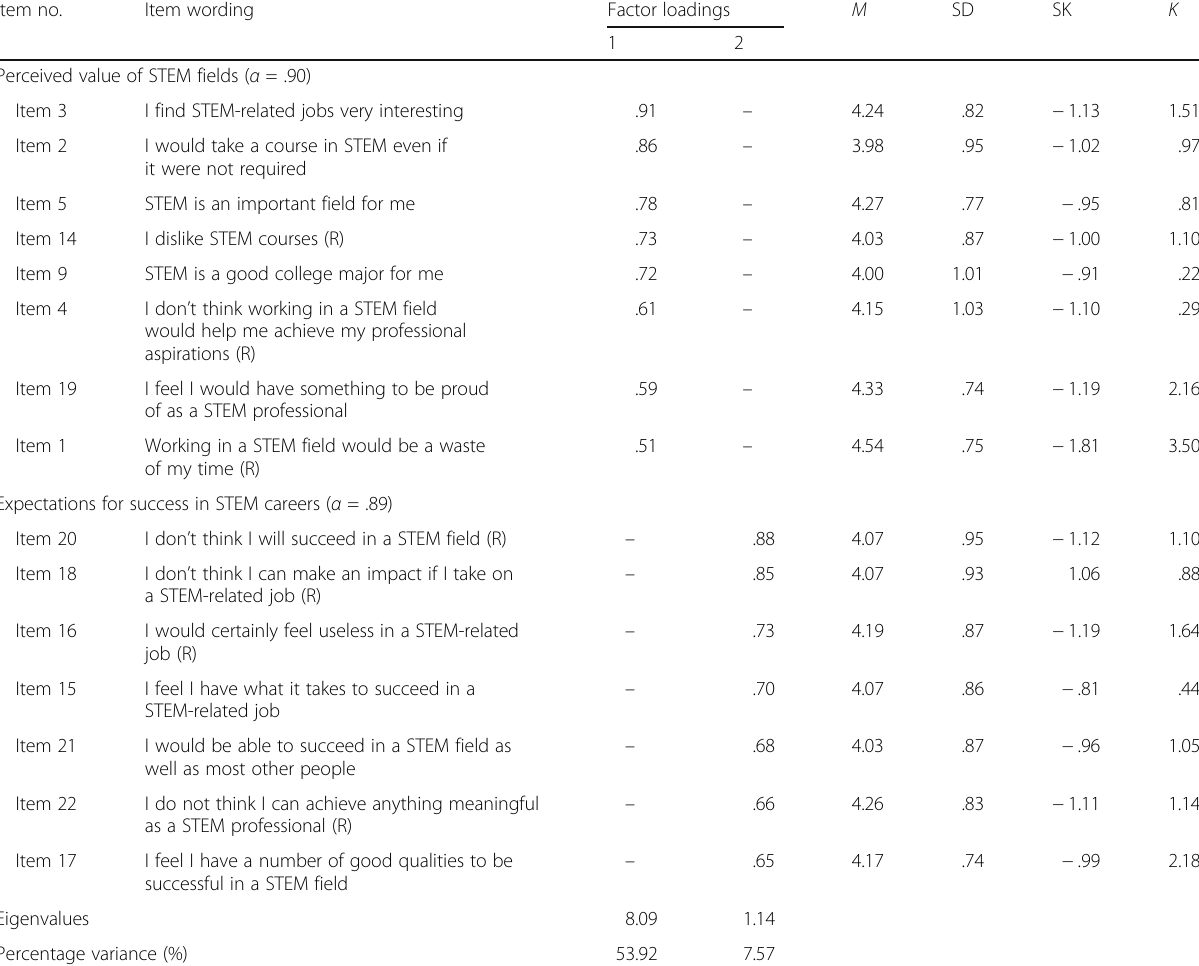
Table 1 Final rotated factor loadings, reliability coefficients, means, standard deviations, skewness, and kurtosis Item